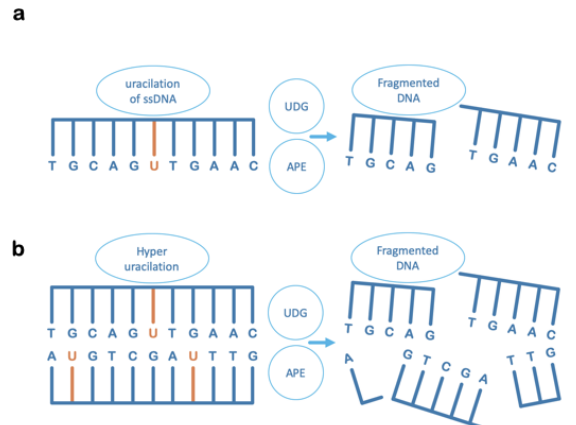
Figure 3. UDG can contextually disrupt DNA integrity. The destructive effect on DNA chain integrity after the action of uracil-DNA glycosylase (UDG) and AP-endonuclease (APE) during initiation of BER, on uracil-containing DNA in situations where: ( a ) Uracil occurs in a single-stranded DNA molecule, in which case there could be stalling or disruption of DNA replication, or of ssDNA-transfer processes such as in bacterial conjugation or in virus replication or packaging. ( b ) There are unusually high levels of uracil in duplex DNA, in which case backbone breaks will be enzymatically created on both strands of dsDNA at close proximity. At short oligonucleotide lengths, the hydrogen bonding forces between complementary base pairs are insufficient to resist the thermal disintegration of the duplex, and the consequence is chain fragmentation that is incompatible with high-fidelity DNA repair.